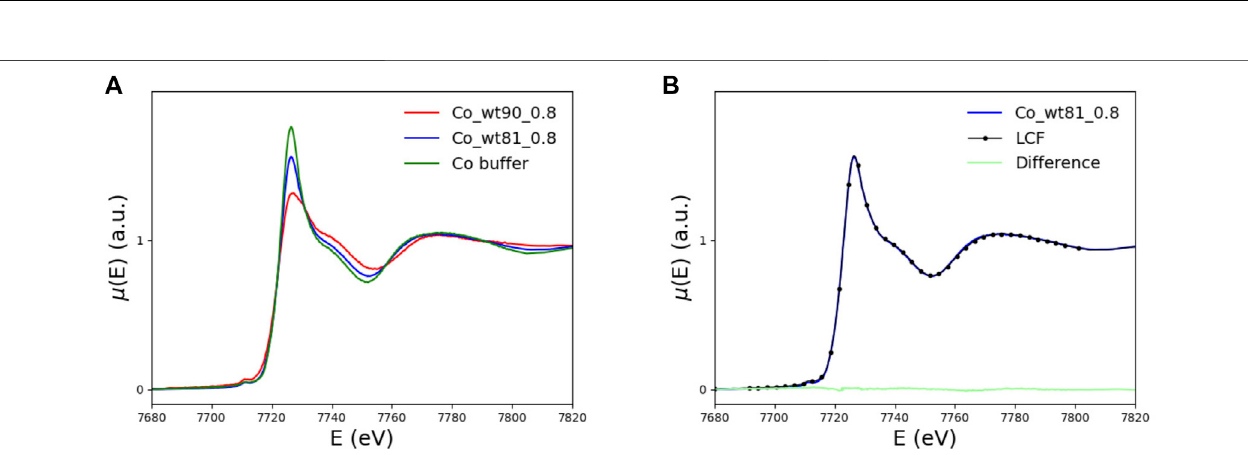
FIGURE 6 | (A) XANES spectra of the FXN samples including (wt_81_0.8, blue curve) and not including (wt_90_0.8, red curve) the N-terminal 81-90 disordered region, compared with the buffer spectrum (green curve). (B) XANES spectrum of the long, wt_81_0.8, fragment (blue curve) compared to the spectrum obtained as a linear combination of 43% of wt_90_0.8 and 57% of buffer spectra (black dotted). In light green, we plot the difference